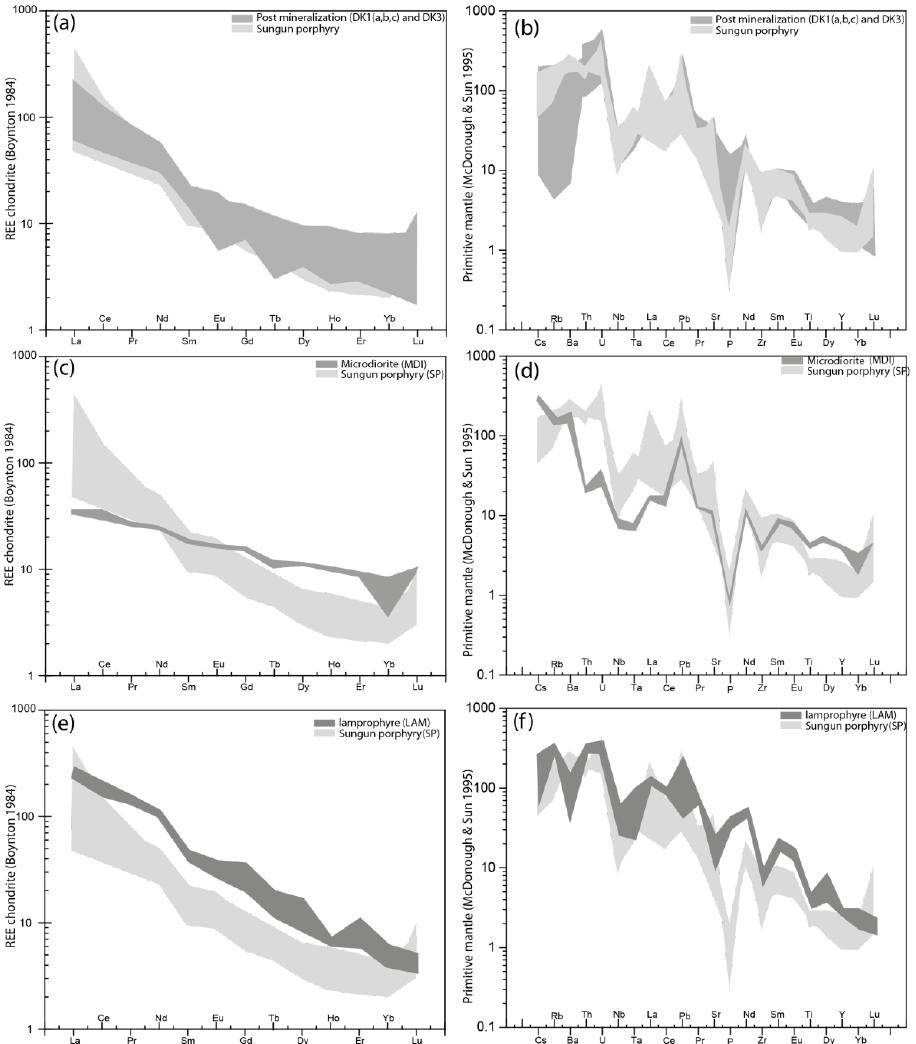
Figure 13. ( a ) Chondrite-normalized REE patterns for the quartz-monzonite stock, diorite and quartz diorite dykes [39]; ( b ) primitive mantle-normalized rare earth elements patterns for the quartz-monzonite stock, diorite and quartz diorite dykes [43]; ( c ) chondrite-normalized diagram [39] for the micro diorite dykes; ( d ) primitive mantle-normalized trace element diagram [43] for micro diorite dykes; ( e ) chondrite-normalised REE diagram for the lamprophyre dykes [39]; ( f ) primitive mantle-normalised multi element diagrams for the lamprophyre dykes [43].